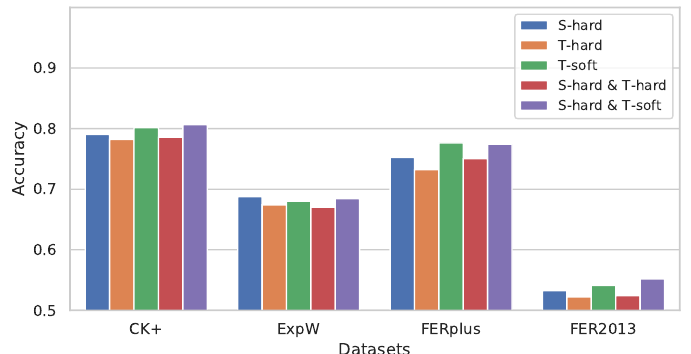
Figure 5. Evaluation of pseudo-assignment